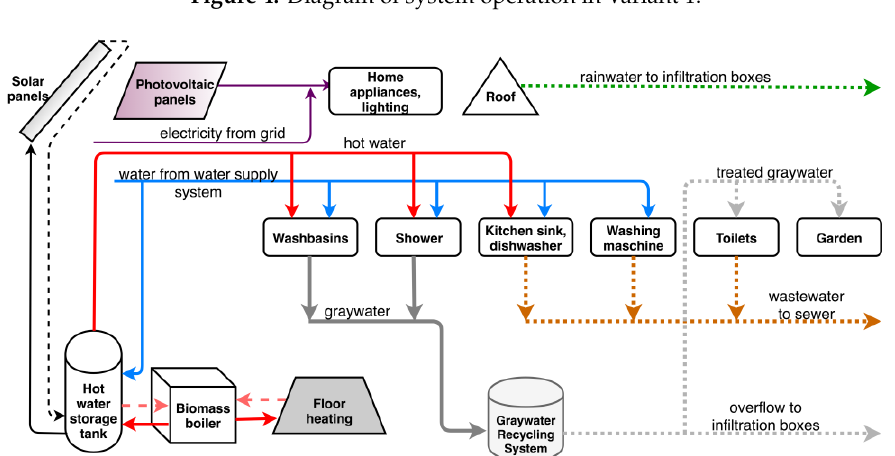
Figure 5. Diagram of system operation in Variant 2.